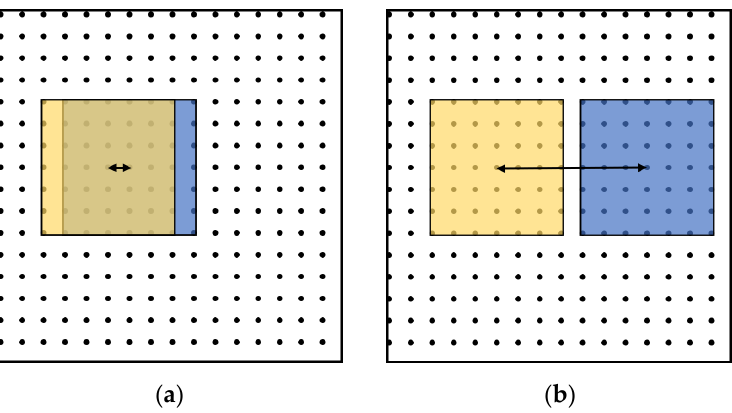
Figure 3. Two windows of the filter for BMS: ( a ) overlapping; ( b ) traversal